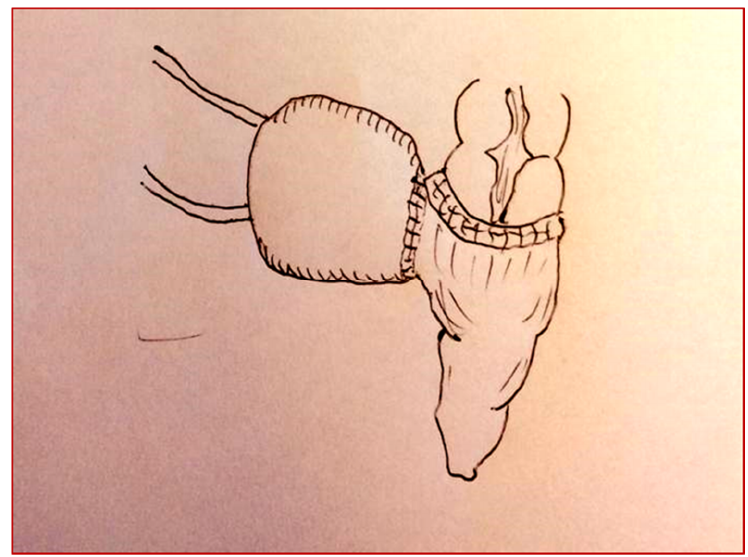
Figure 7. Cologne pouch technique: creation of the pouch.